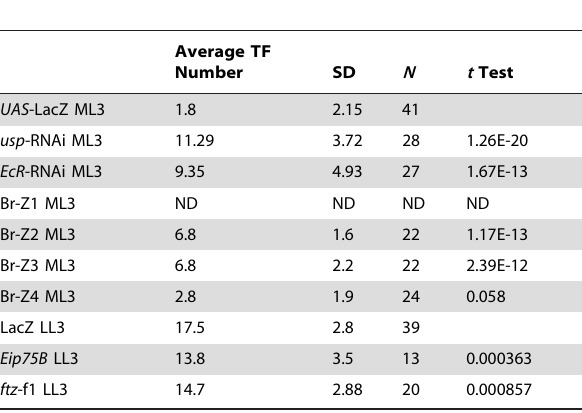
Table 1. Effects of ecdysone signaling components on TF formation.